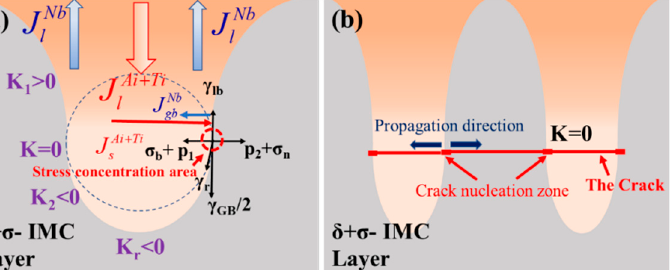
Figure 12. ( a ) Schematic illustration of the related stress interactions coupled with element diffusion, ( b ) Schematic illustration of crack nucleation and propagation.